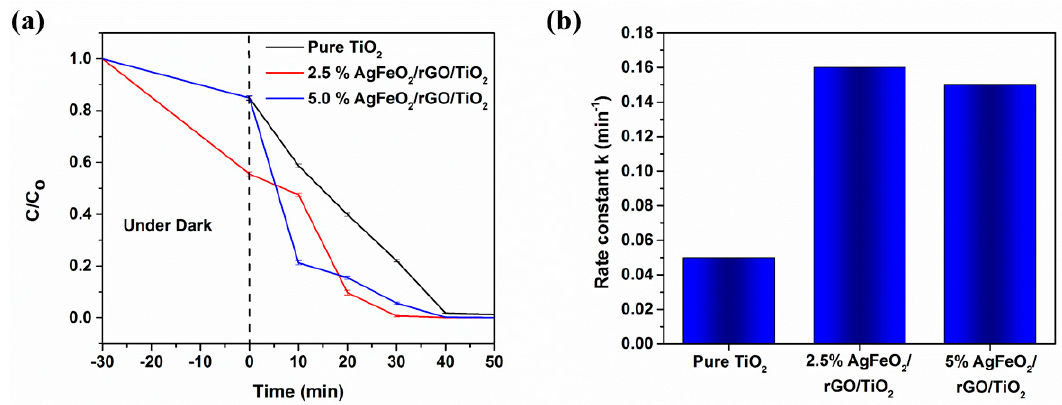
Figure 5. ( a ) Photocatalytic decolorization of MB dye solution, and ( b ) rate constants measured for commercial TiO 2 , 2.5% and 5% AgFeO 2 / rGO / TiO 2 samples. Effect of Parameters